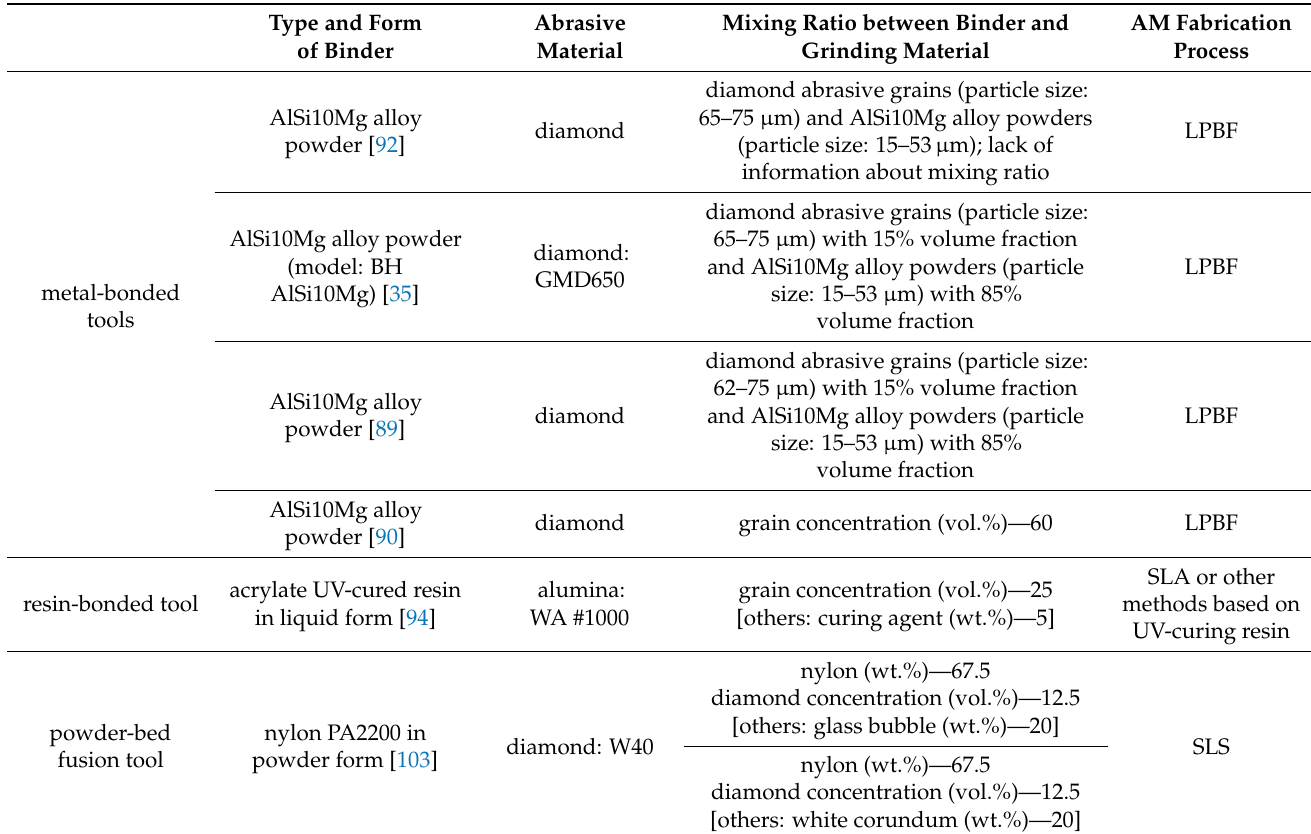
Table 4. Materials and their compositions used to manufacture grinding wheels using AM technologies. Type and Form Abrasive Mixing Ratio between Binder and of Binder Material Grinding Material